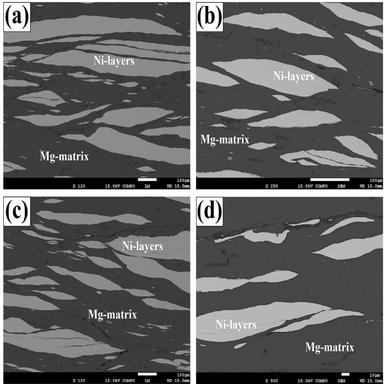
FE-SEM images showing the fragmentation of nickel foil layers within the magnesium matrix after AFF treatment and formation of Mg/Ni multilayers composite structure for samples with (a, b) low and (c, d) high contents of Mg at (a, c) low and (b, d) high magnifications.